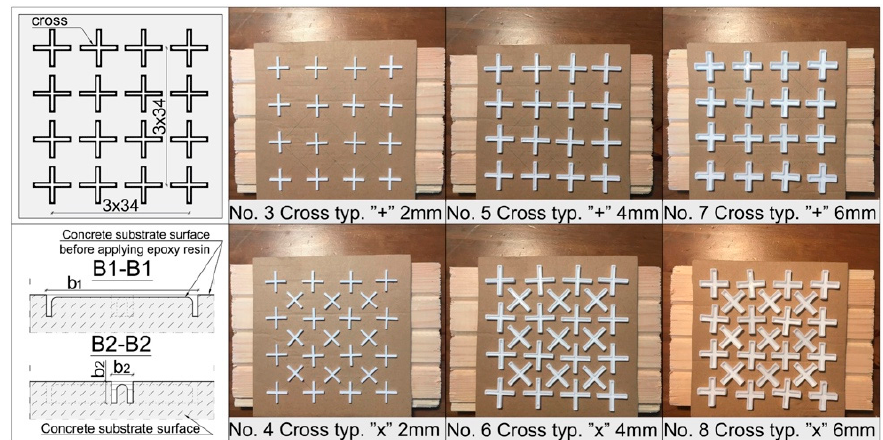
Figure 2. The applied imprinting method for texturing the surface of the concrete substrate (dimensions: b 1 = 20, 28 mm; b 2 = 2, 4, 6 mm).